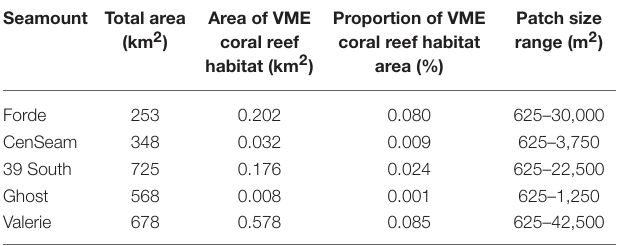
TABLE 6 | Total seamount area within the modeled depth range (265–2,000m), estimated area and proportion of VME coral reef habitat, and range of VME habitat patch size.